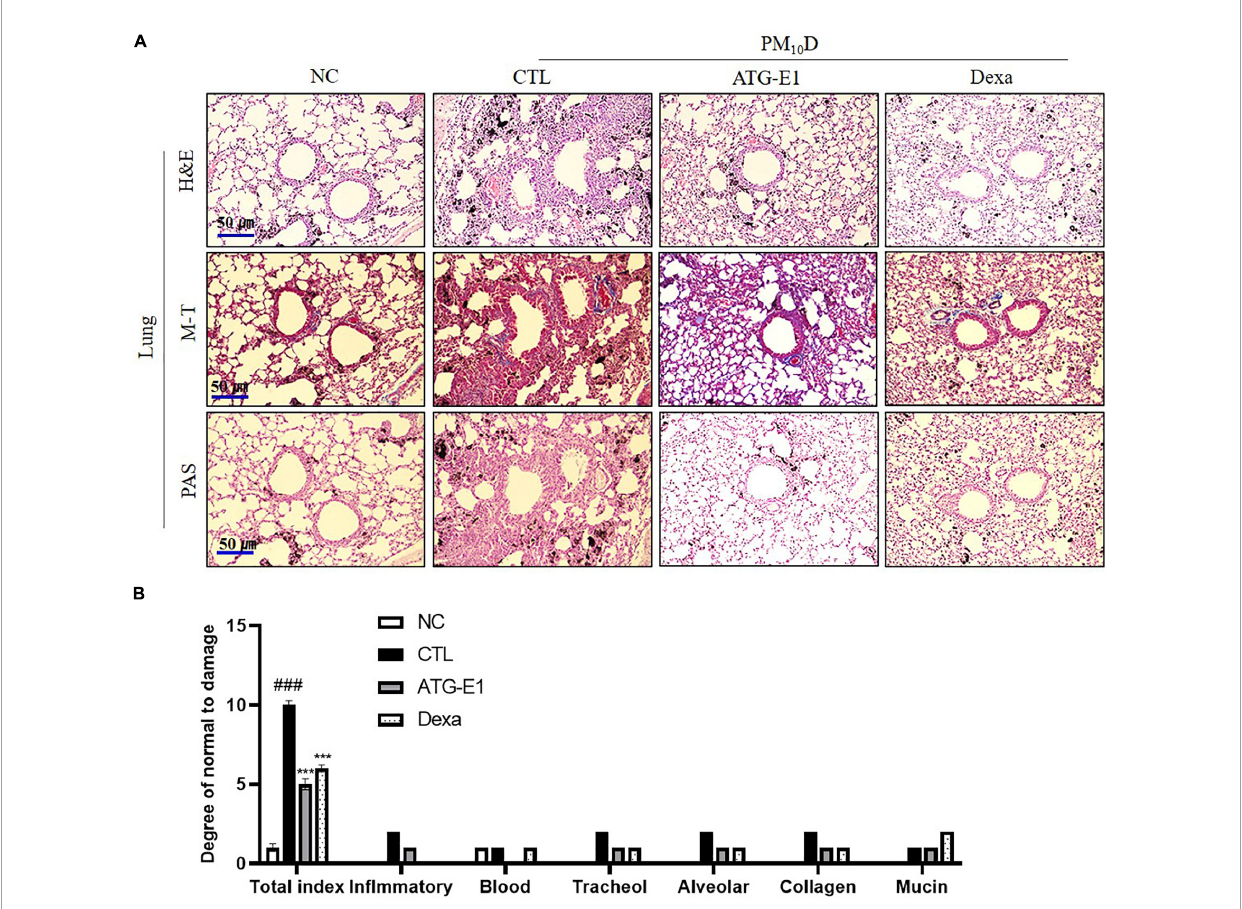
FIGURE3 Effects of L. paracasei ATG-E1 on histological analysis in a PM 10 D-induced airway inflammation animal. (A) H&E, MT, and PAS staining of lung tissues and (B) quantitative analyses of the degree of lung tissue damage. The data are presented as means ± SEM ( n = 8). ### p < 0.001 vs. NC; *** p < 0.005 vs. CTL. NC: normal mice; CTL: PM 10 D-sensitized control mice; Dexa: 3 mg/kg dexamethasone-treated PM 10 D-sensitized mice; ATG-E1: 4 × 10 9 CFU/day of L. paracasei ATG-E1-treated PM 10 D-sensitized